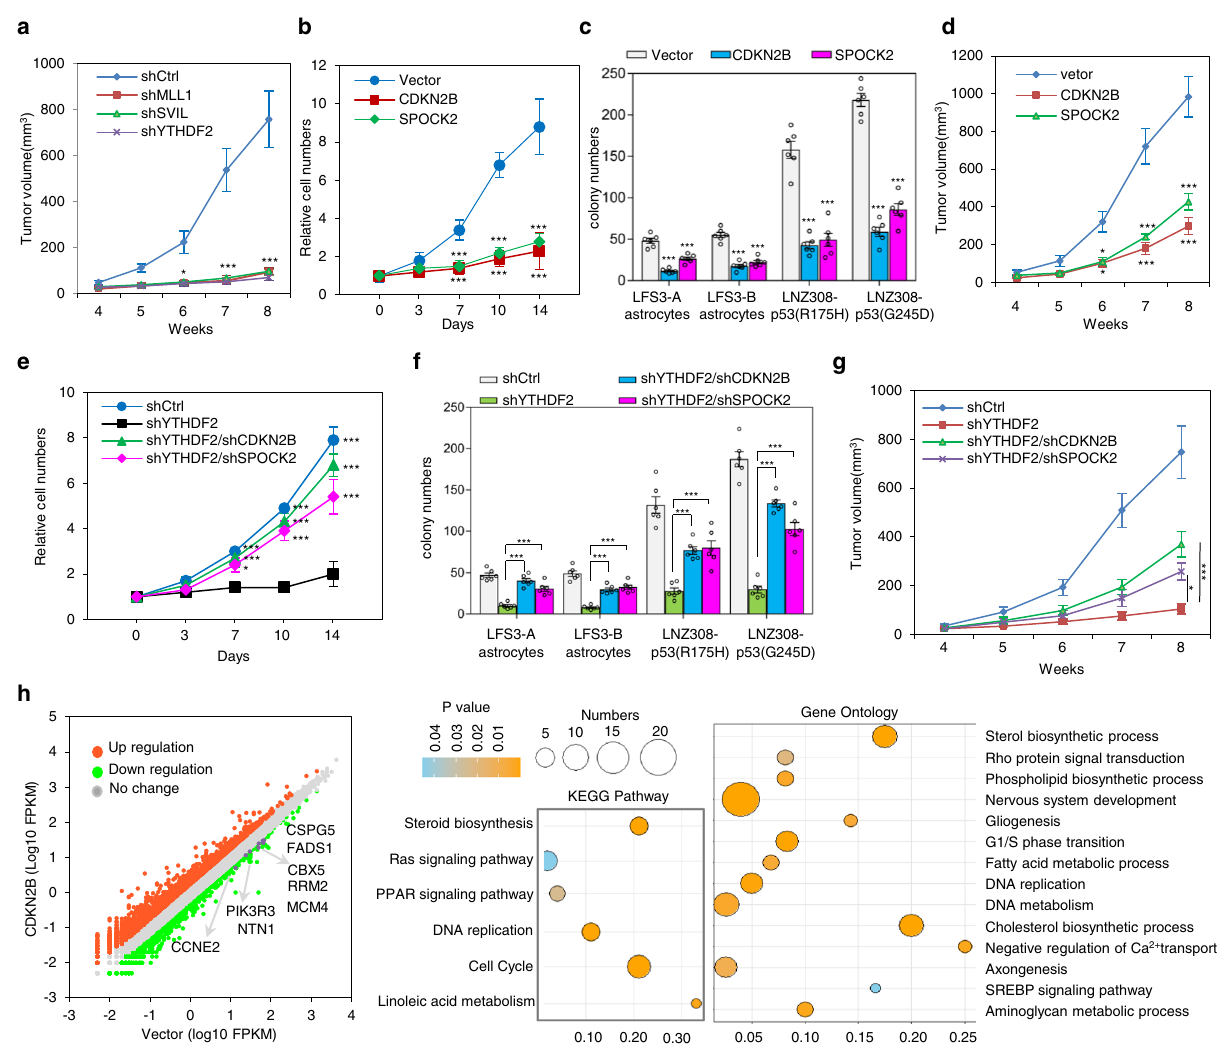
Fig.6|YTHDF2-mediated CDKN2B and SPOCK2 mRNAdegradationcontributes to mutant p53-associated malignancy. a In vivo mouse xenograft study demon- strates that knockdown of YTHDF2, SVIL, or MLL1 hampers LNZ308-p53(G245D) tumor growth ( n =4 biologically independent mice). The sizes of the tumors were measured at the indicated time. b Expression of CDKN2B or SPOCK2 inhibits cell proliferation of LFS astrocytes ( n =6 biologically independent samples). c In vitro AIG assay demonstrates ectopic expression of CDKN2B or SPOCK2 leading to decreased colony numbers of LFS astrocytes. All colonies are counted and mea- sured after 2-month culture ( n =6 biologically independent samples). d In vivo mouse xenograft study shows ectopic expression of CDKN2B or SPOCK2 abro- gating LNZ308-p53(G245D) tumor growth ( n =3 biologically independent mice). The sizes of the tumors were measured at the indicated time. e Knockdown of CDKN2B or SPOCK2 rescues YTHDF2 depletion-induced growth inhibition in LFS astrocytes ( n =6 biologically independent samples). f In vitro AIG assay demon- strates knockdown of CDKN2B or SPOCK2 rescuing in vitro colony formation of